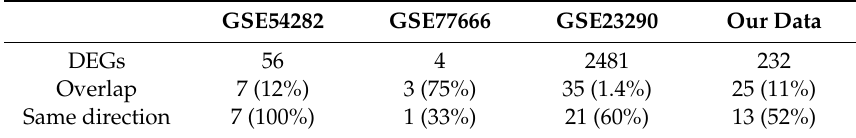
Table 4. Overlap between microarray studies on the putamen from PD patients.